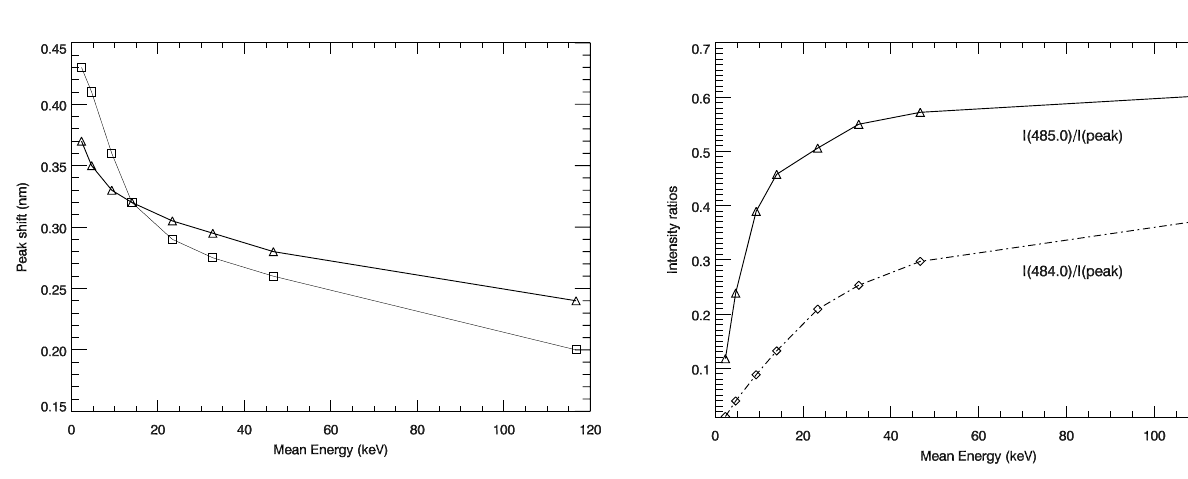
Fig. 1. Synthetic H- β line profiles calculated for proton precipi- tation with characteristic energy E 0 = 2keV (top) and 5keV (bot- tom). The calculated H- β line profiles are shown by the dotted lines, and these lines convolved with a Gaussian response function with FWHM=0.5nm by the solid lines.